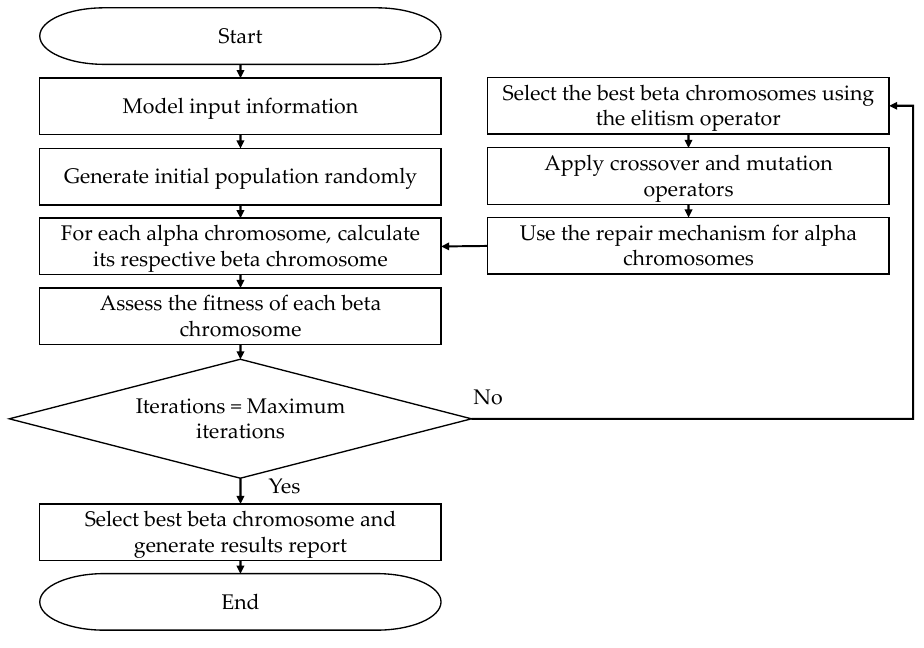
Figure 1. Flowchart for the genetic algorithm.